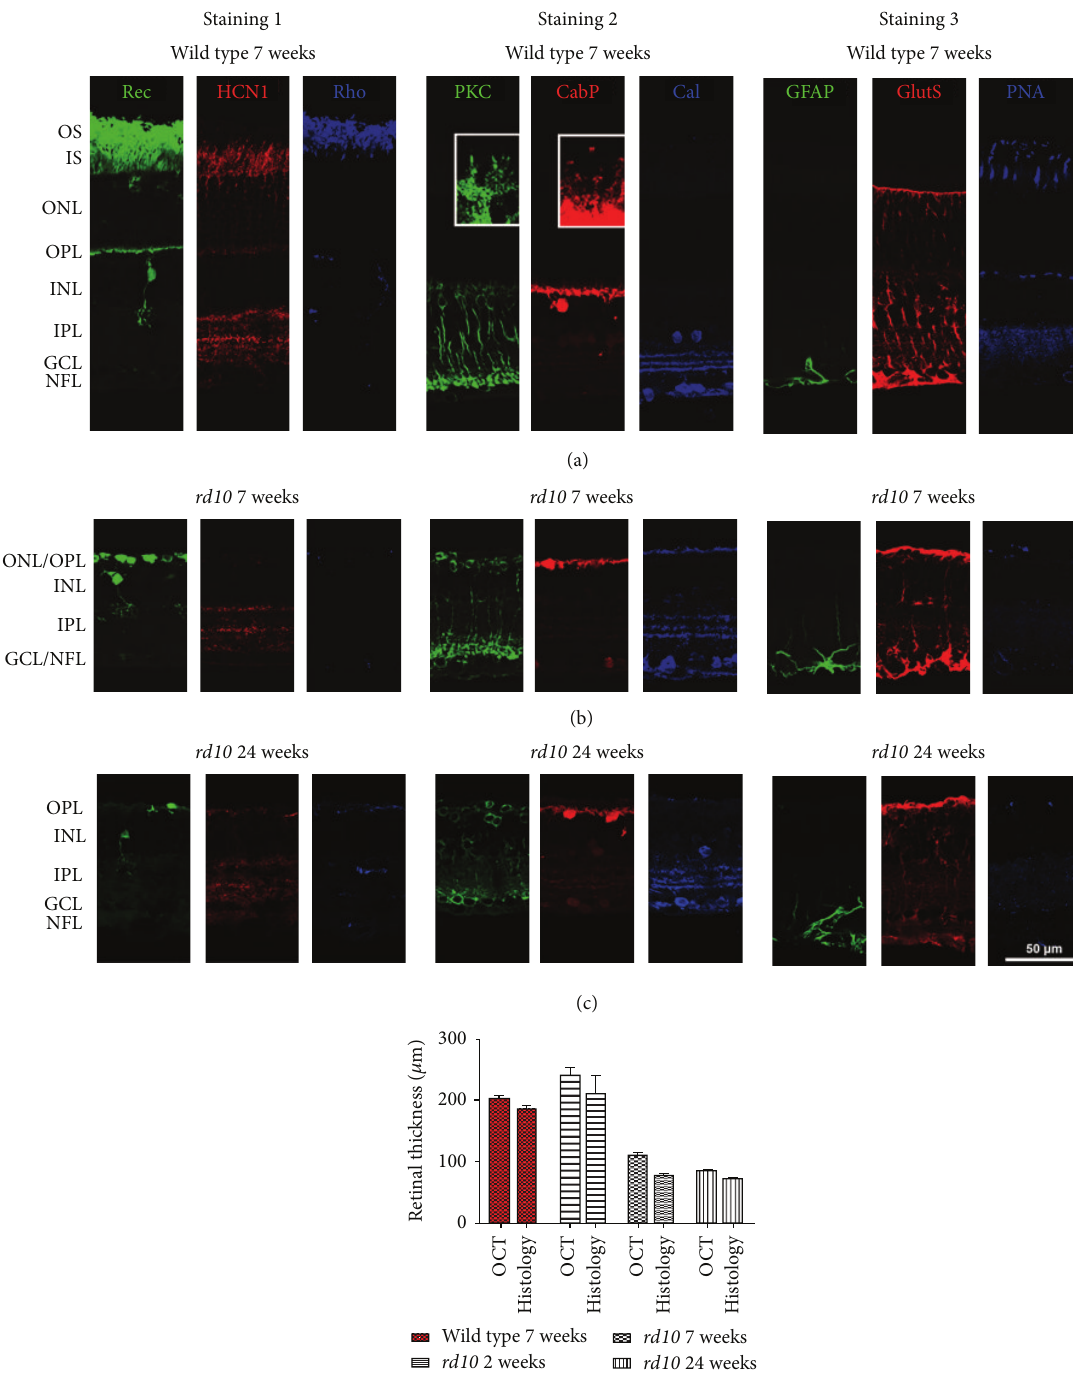
Figure 5: Immunohistochemical staining of wild type (a) and rd10 retina at 7 weeks (b) and at 24 weeks (c). Staining 1: recoverin (all photoreceptors and type 2 bipolar cells) in green; HCN1 (photoreceptor somata and inner segments, processes in IPL, red); rhodopsin (rod outer segments, blue; puncta in the inner retina represent blood vessels labeled unspecifically by the secondary antibody). The ONL in the rd10 mouse is considerably reduced to only one row of somata at 7 weeks (b) and completely lost at 24 weeks (c). Staining 2: rod bipolar cells (PKC 𝛼 ,green),horizontalcells(anti-28 kDacalcium-bindingprotein=CabP,red),andamacrinecells(calretinin,blue).Insetsshowprocesses of rod bipolar and horizontal cells at higher magnification. In rd10 retina, such processes are lost. Staining 3: astrocytes (anti-GFAP, green), M¨uller cells (anti-glutamine synthetase = GlutS, red), and cone outer and inner segments (PNA, blue). In rd10 mice, M¨uller cell processes are also GFAP-positive. Scale bar represents 50 𝜇 m in overviews and 10 𝜇 m in insets. Bar diagram in (d) illustrates retinal thickness evaluated in vivo by OCT ( 𝑛 = 3 per age group; both eyes per 𝑛 ) in comparison to measurements performed in immunohistochemistry ( 𝑛 > 6 ; both eyes per 𝑛 ). Thickness values in vivo and in vitro differ by 10 to 15%. Values represent mean ±